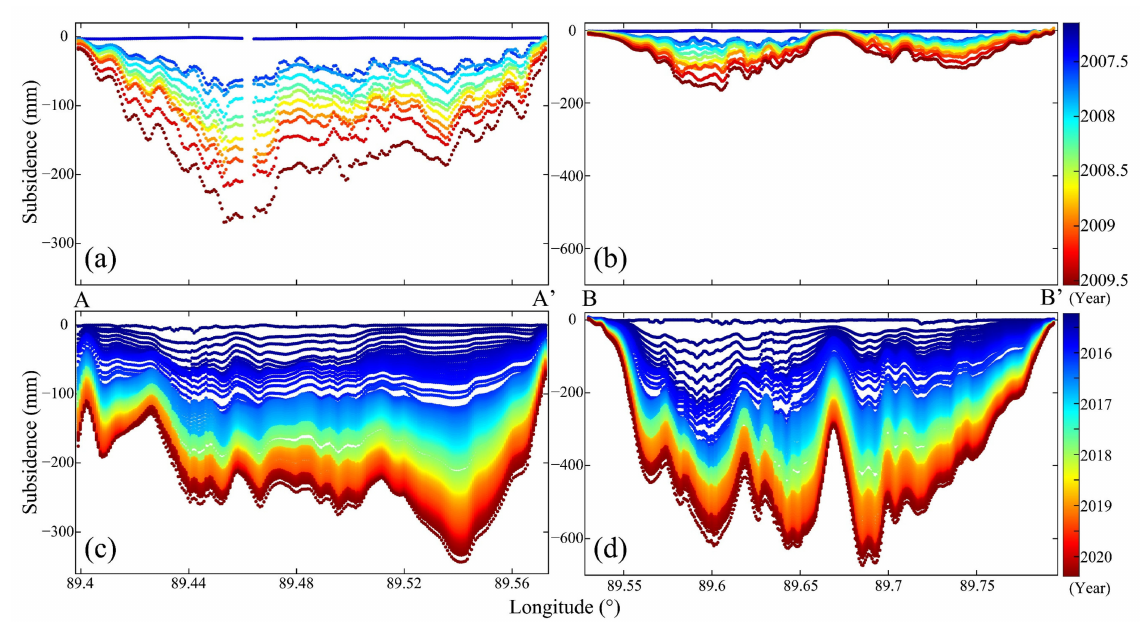
Figure 5. The long-term cumulative deformation at the profiles ( a , c ) A-A (cid:48) and ( b , d ) B-B (cid:48) in Figure 4.